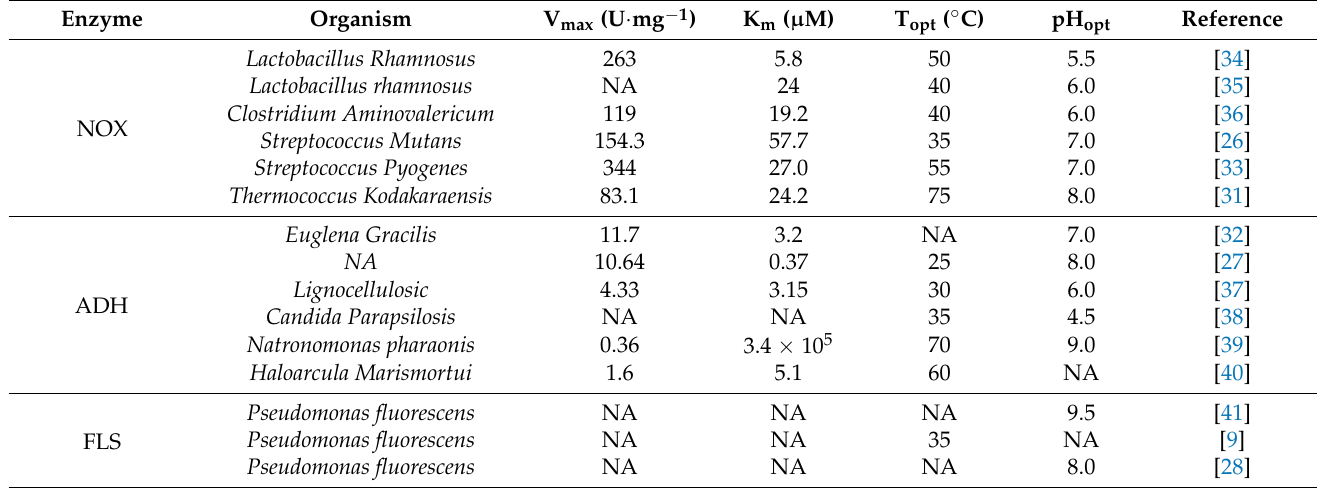
Table 1. Biochemical and kinetic properties of NOX, ADH, and FLS from various